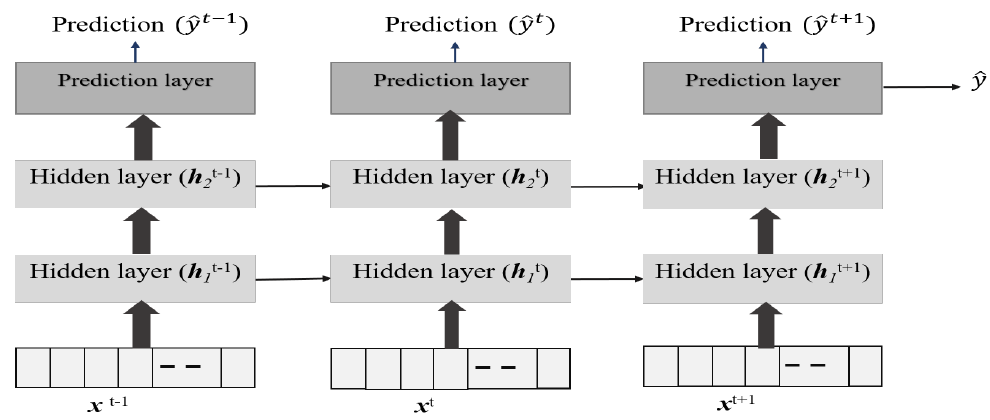
Figure 6. Structure of the LSTM Network for Blood Glucose Level